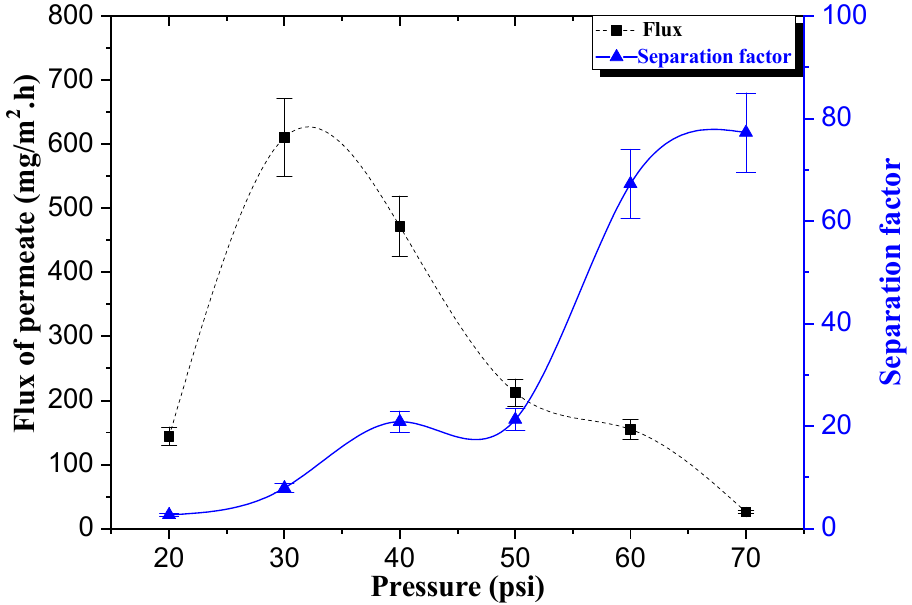
Figure 12. The flux of permeate and separation factor of pervaporation process at 25% ethanol from water using poly (MMA- co -MA) membrane under different nitrogen pressures.